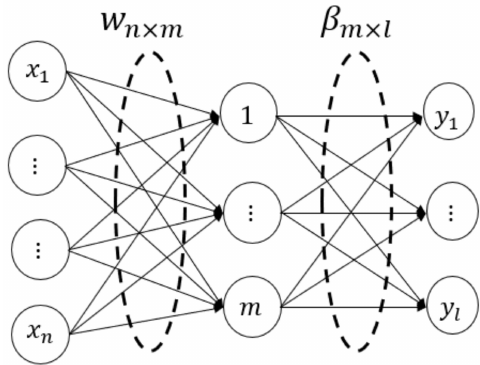
Figure 1. ELM model structure